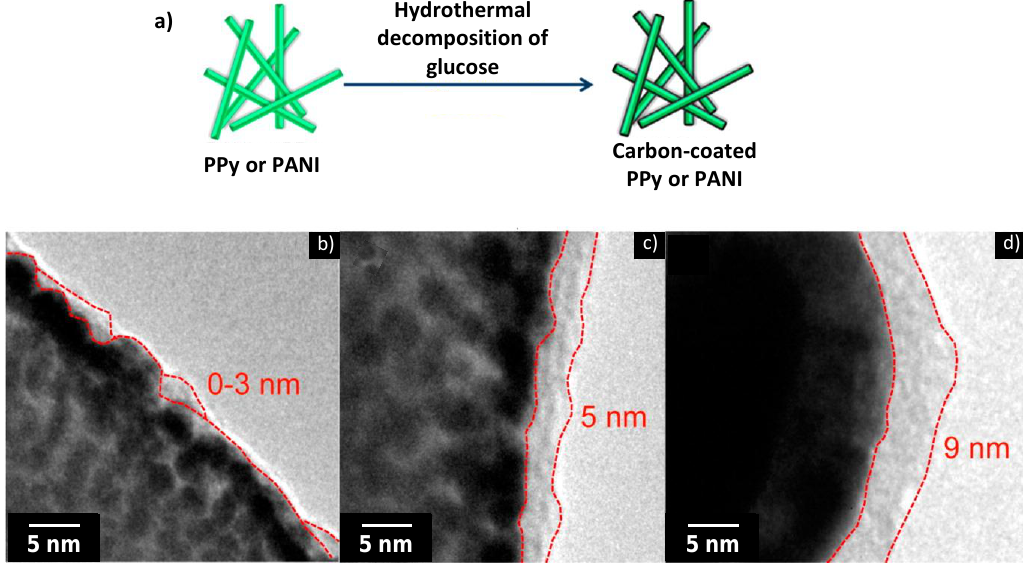
Figure 12. ( a ) Schematic of the carbonaceous coating procedure using glucose as the carbon precursor. ( b – d ) TEM images of carbon-coated PPy samples with different carbonaceous shell thicknesses, which was controlled via the reaction time for the hydrothermal deposition of glucose: ( b ) 1, ( c ) 2, and ( d ) 3 h. With permission from [93]; Copyright 2014, American Chemical